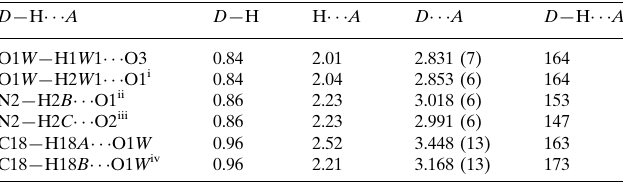
Hydrogen-bond geometry (A˚ , (cid:4)